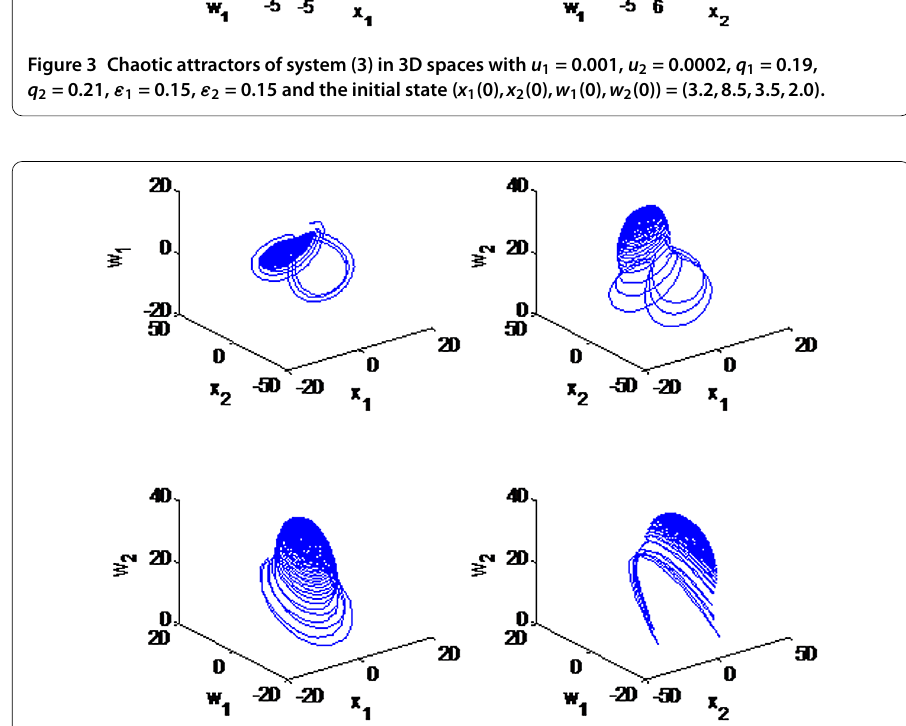
Figure 4 Chaotic attractors of system (3) in 3D spaces with u 1 = 0.2, u 2 = 0.5, q 1 = 5.9, q 2 = 9.15, ε 1 = 0.5, ε 2 = 0.1 and the initial state ( x 1 (0), x 2 (0), w 1 (0), w 2 (0)) = (2.2,2.0,10.5,20).